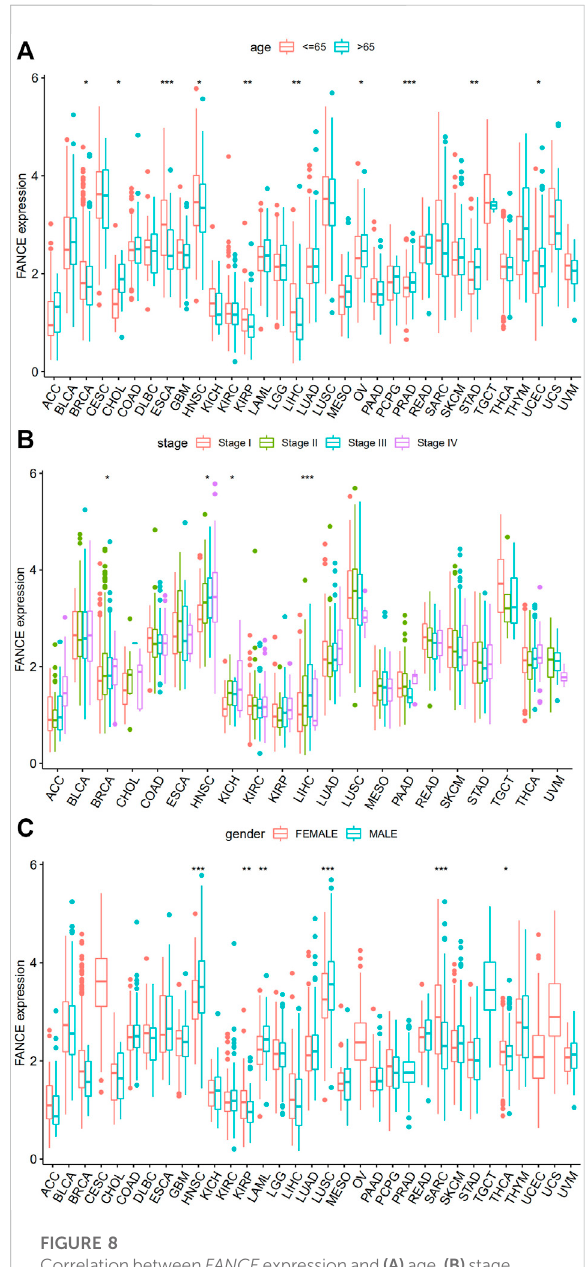
FIGURE 8 Correlationbetween FANCE expressionand (A) age, (B) stage, and (C) gender in 33 cancers from TCGA database. * p < .05; ** p < .01; and *** p <